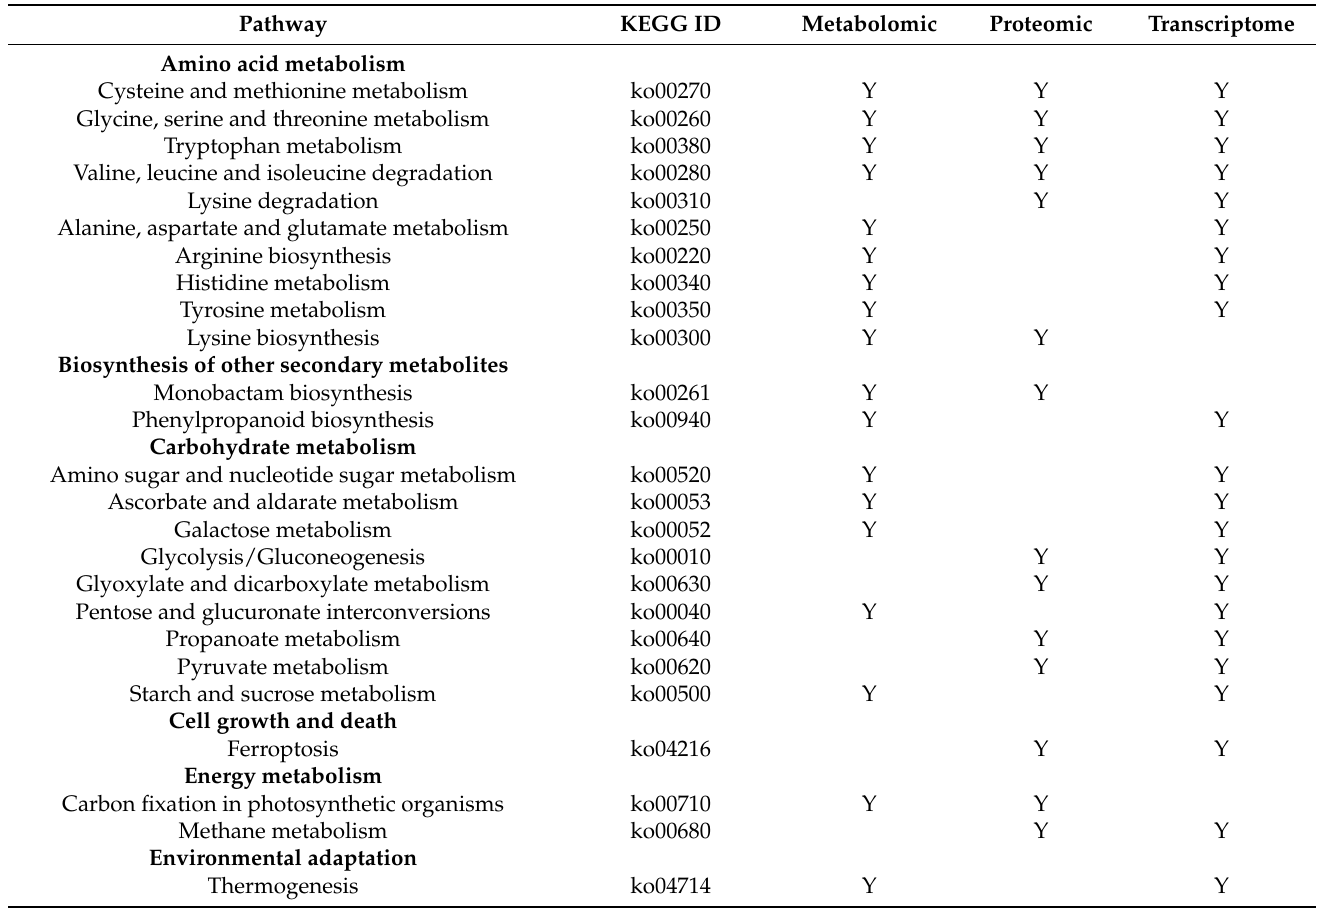
Table 2. Statistics of overlapping KEGG